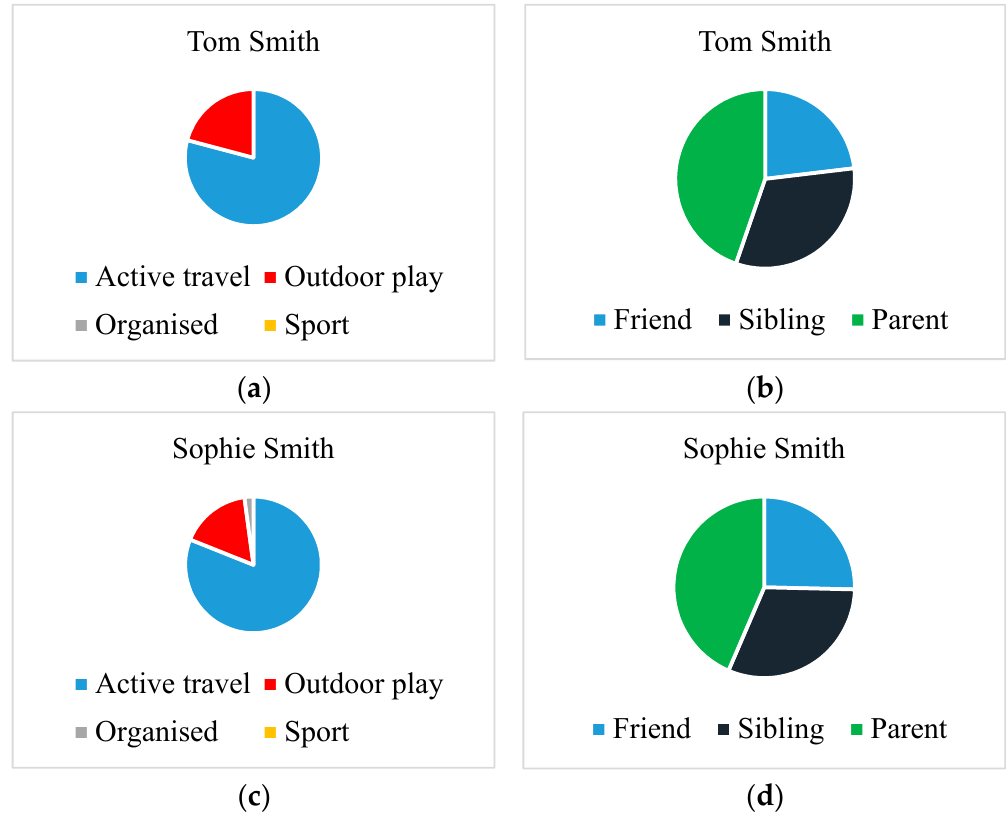
Figure 2. ( a , b ) Physical activity (PA) diary data for Tom Smith, and ( c , d ) PA diary data for Sophie Smith.